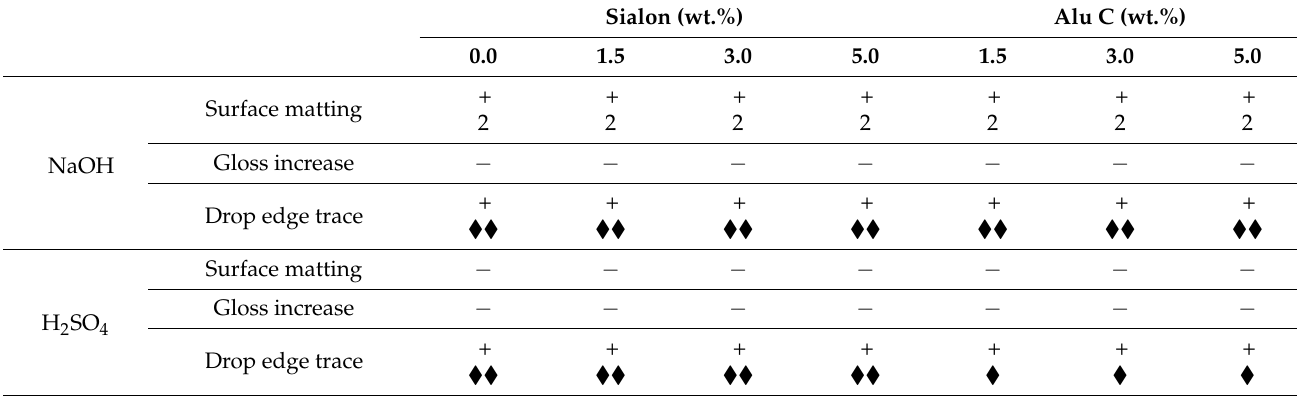
Table 1. The results of the test for the resistance of varnish coatings to